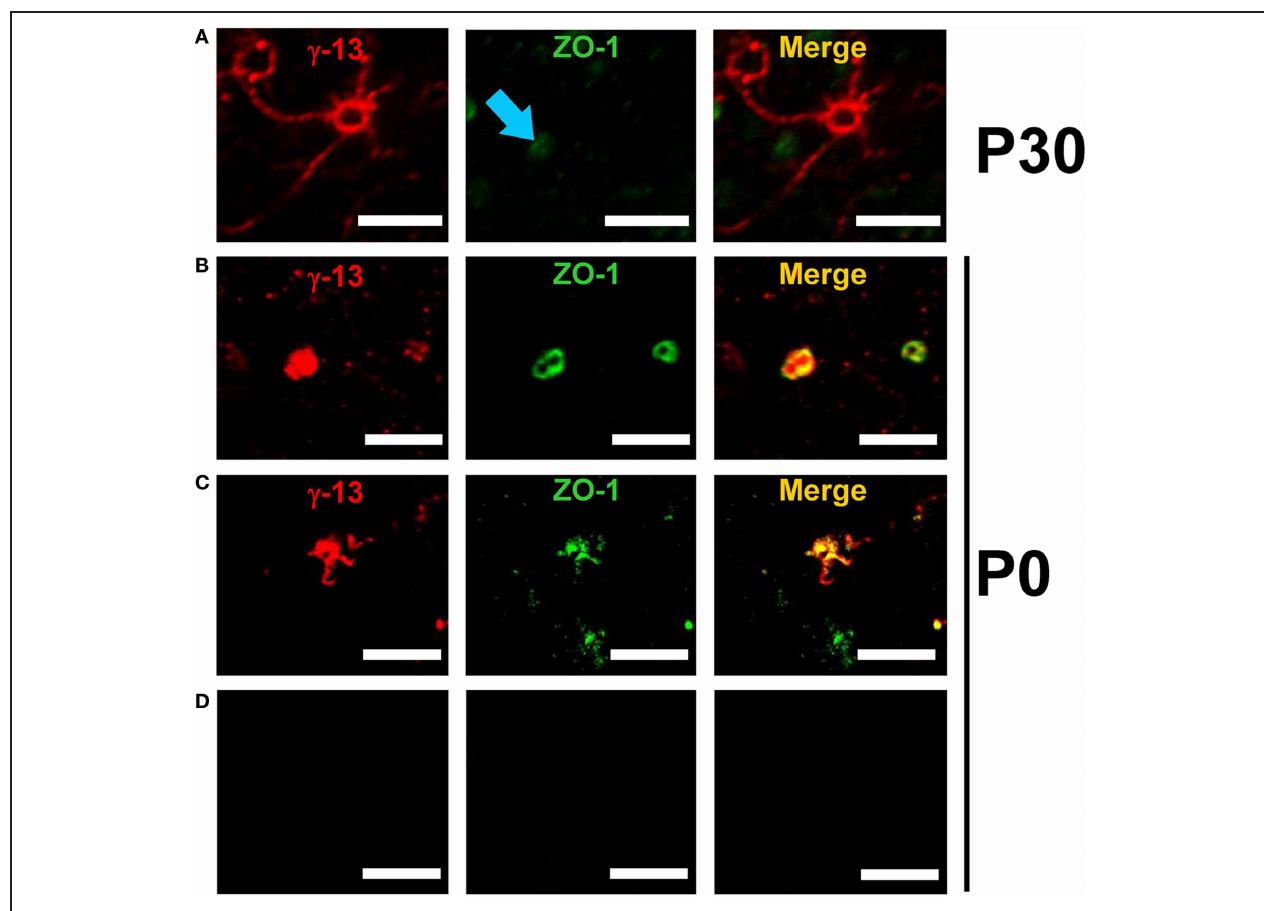
ZO-1 (blue arrow) does not co-localize with the G γ -13 immunostaining. (B) In P0 mice a strong co-localization within olfactory dendritic knobs devoid of cilia as well as neurons bearing small-sized cilia (C) is observed. (D) Control experiment performed by omitting the primary antibody. Scale bar 5 μ